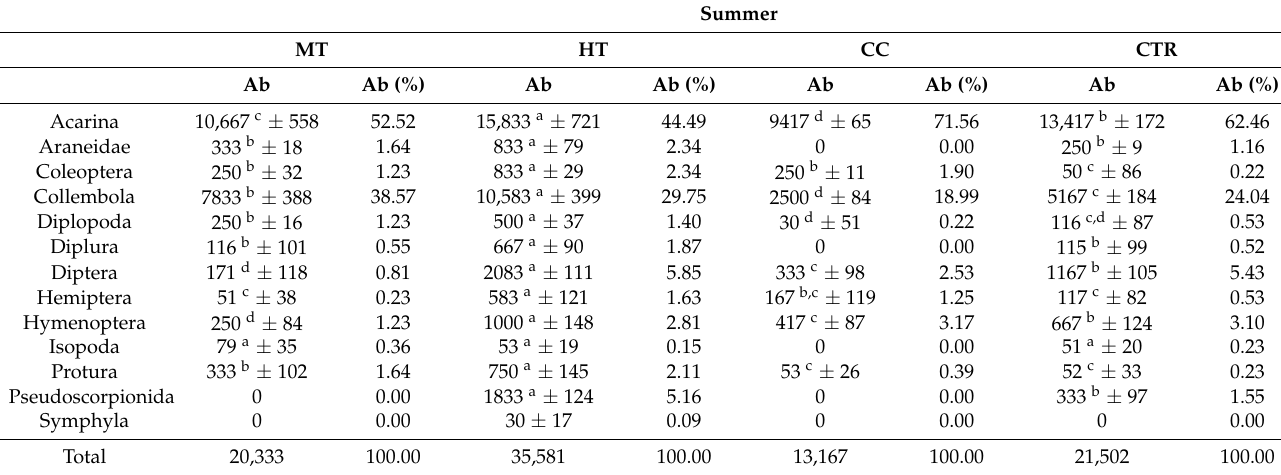
Table 3. Total number of individuals (Ab) and percentage abundance (% Ab) of arthropods captured in summer in soil under differently managed plots of a Pinus laricio plantation. HT: intensive thinning; MT: moderate thinning; CC: clear cut; and CTR: control. The data are the means of two consecutive years (2014 and 2015). Different letters in the same column indicate, within each season, significant differences (Tukey’s test, p ≤ 0.05).